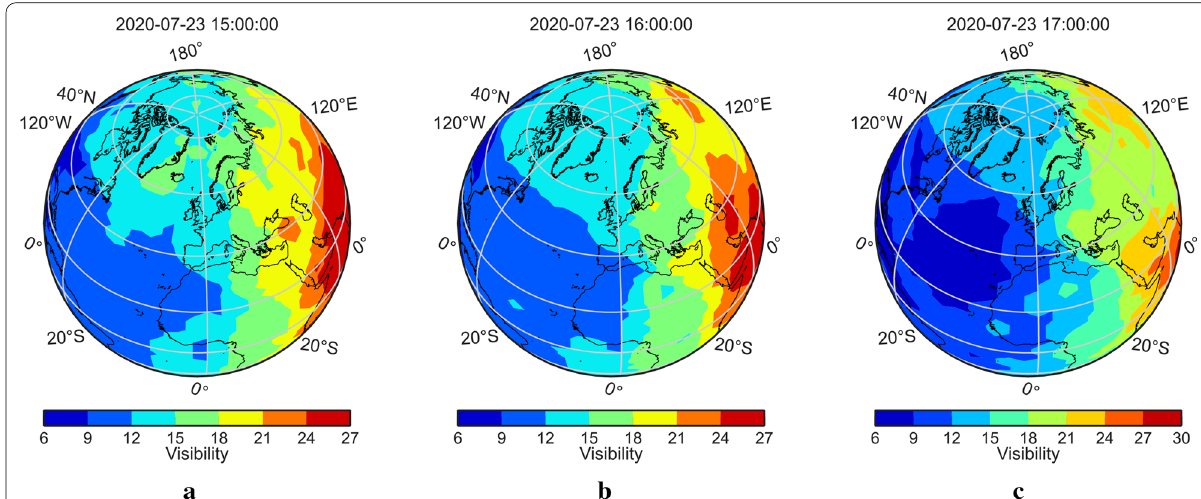
Fig. 2 The number of the visible BDS satellites with elevation angles above 5° at a GPS time 15:00:00, b 16:00:00, and c 17:00:00 on July 23, 2020. To highlight Britain and its surrounding areas, the far side of the globe is not displayed (the same